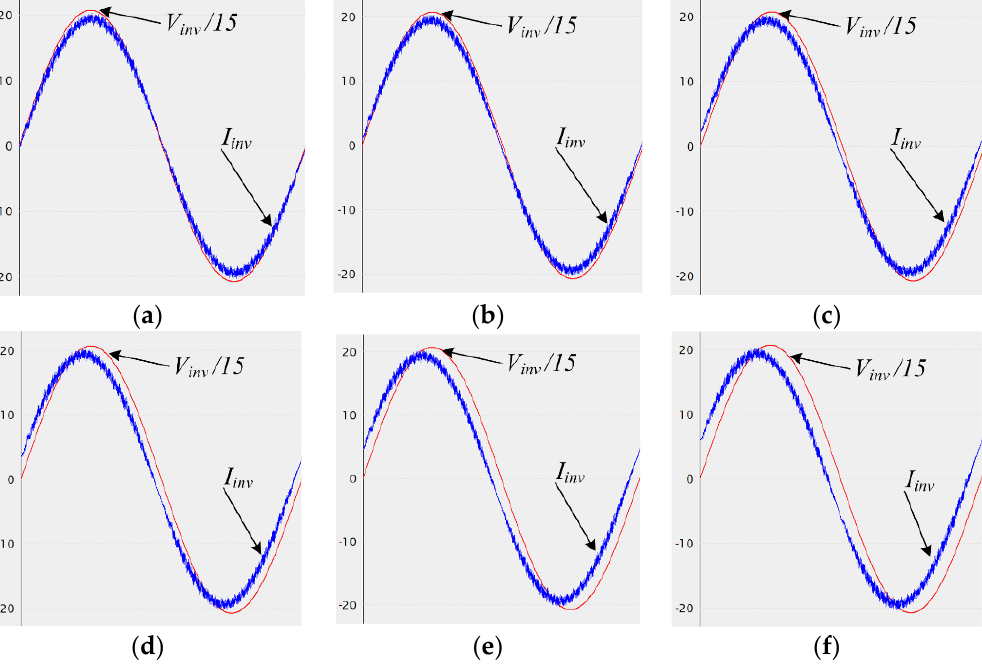
Figure 4. Voltage and current waveforms under RPV method: ( a ) θ RPV = 0%, ( b ) θ RPV = 1%, ( c ) θ RPV = 2%, ( d ) θ RPV = 3%, ( e ) θ RPV = 4%, ( f ) θ RPV = 5%. Table 5. Power quality comparison based on total harmonic distortion ( THDi ) under the AFD and RPV anti-islanding implementation.